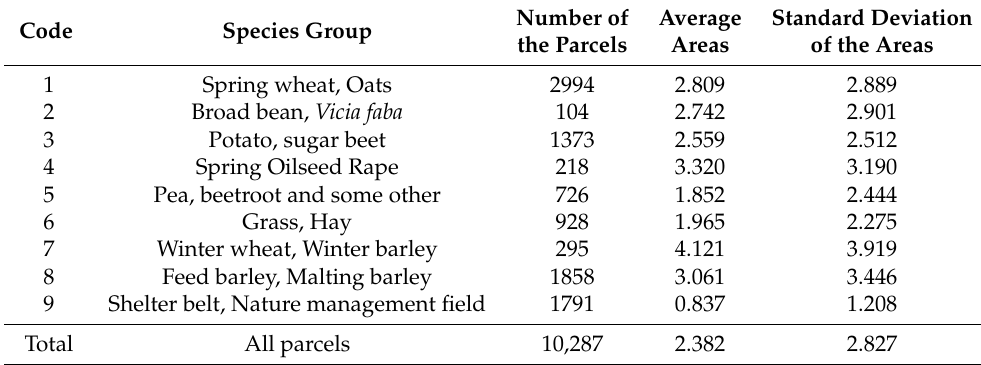
Table 2. The nine species groups, the codes used in the analyses together with number of the parcels, averages, and standard deviations of the areas in the test